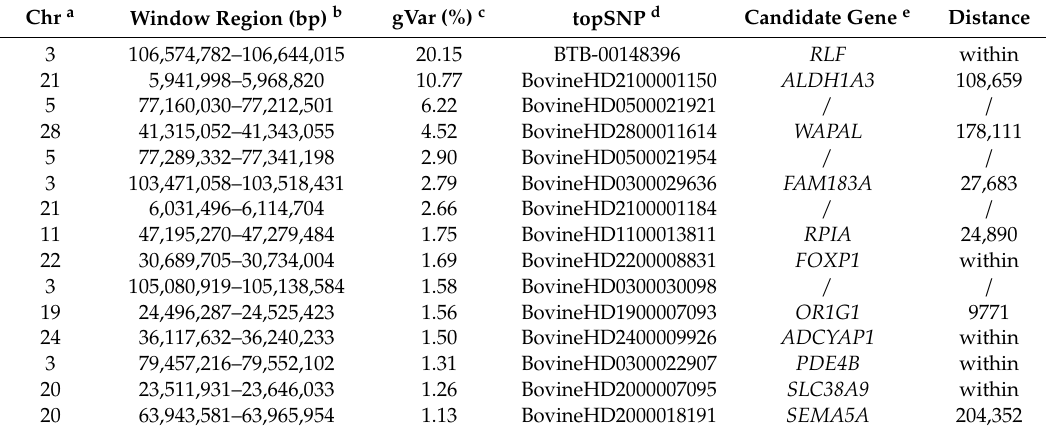
Table 4. Windows that explained > 1% of the additive genetic variance for average daily gain from birth to yearling in Simmental beef